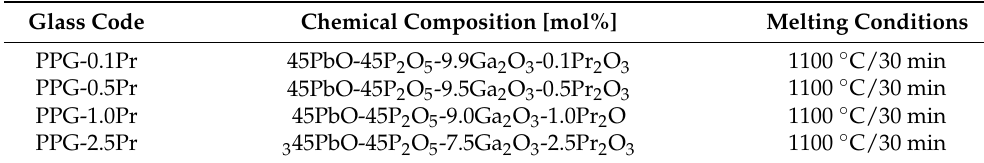
Table 2. Chemical compositions and melting conditions for lead-phosphate glass doped with Pr 3+ . Glass